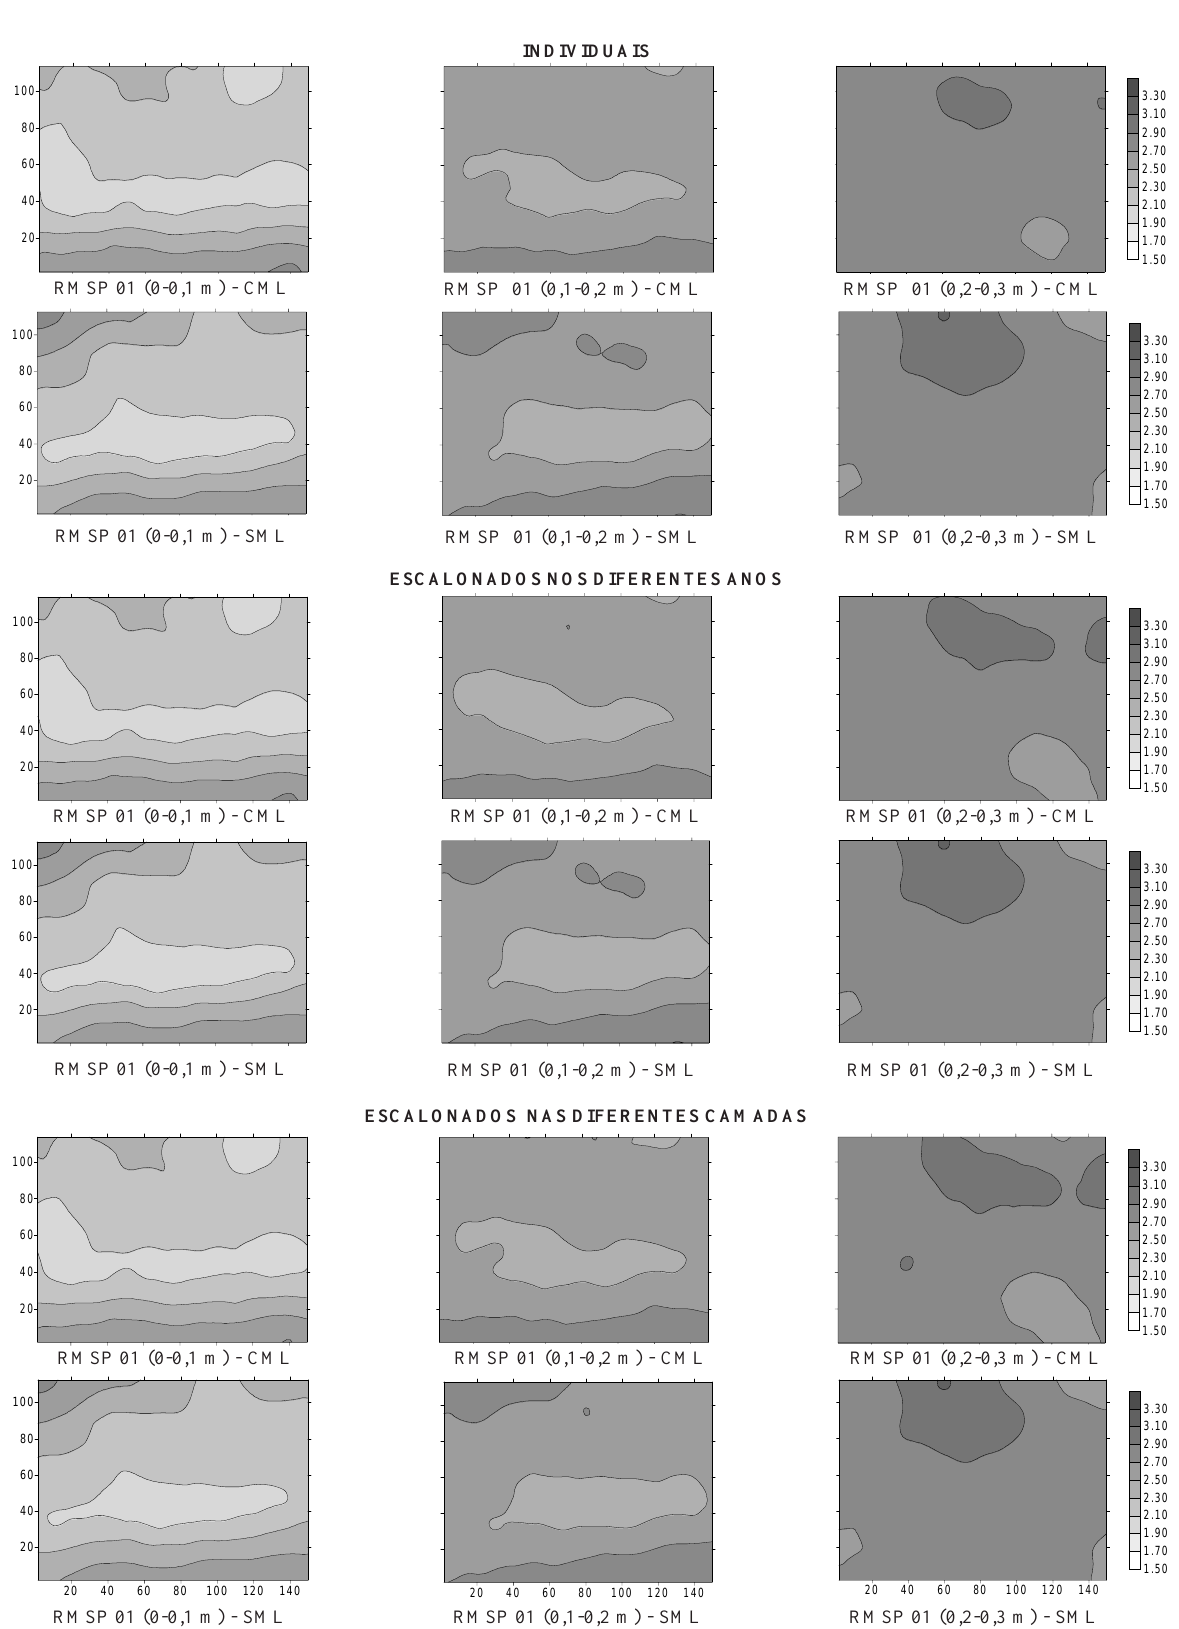
Figura 5. Mapas de contorno da variável RMSP (MPa) do ano de 2001, construídos a partir dos semivariogramas individuais; escalonados nos diferentes anos de amostragem e nas diferentes